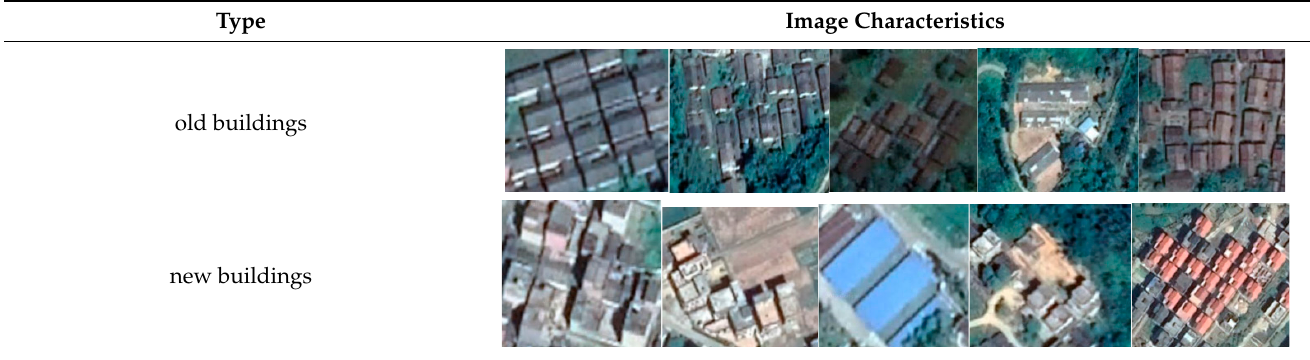
Table 2. The training, validation, and test dataset. One ‐ Class Samples